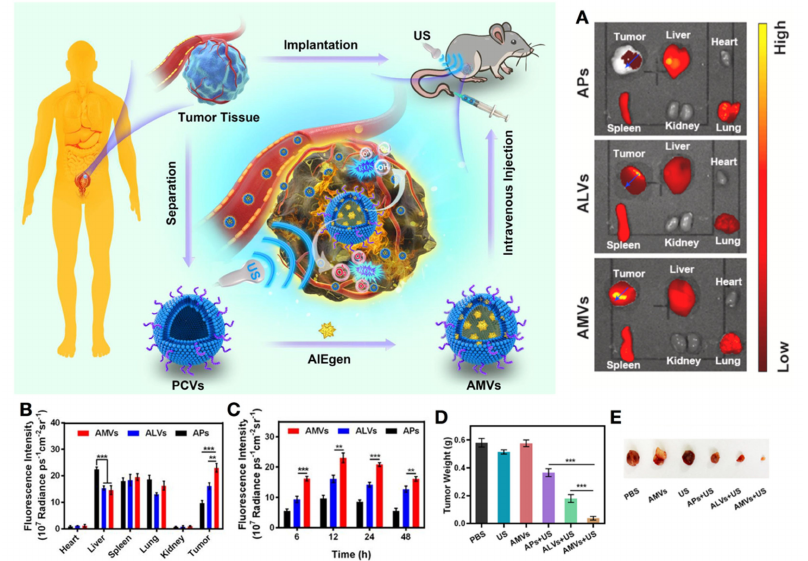
Figure 8. A patient-derived MVs/AIEgen hybrid system (AMVs) for personalized SDT in bladder cancer patient-derived xenograft (PDX) models. ( A ) Ex vivo images of excised organs and tumors of mice bearing PDX were examined at 12 h post-injection of APs, ALVs, and AMVs. ( B ) Fluorescence distribution profile on the specified blue arrows in tumors of ( A ). ( C ) Quantification of the time- dependent fluorescence intensity at the tumor site after various treatments. ( D ) Tumor weight and ( E ) tumor tissues were collected from the PDX mice after various treatments. APs, ALVs, and AMVs: PLGA/AIEgen nanoparticles; ALVs: MVs/AIEgen derived from a cell line. ** p < 0.01; *** p <